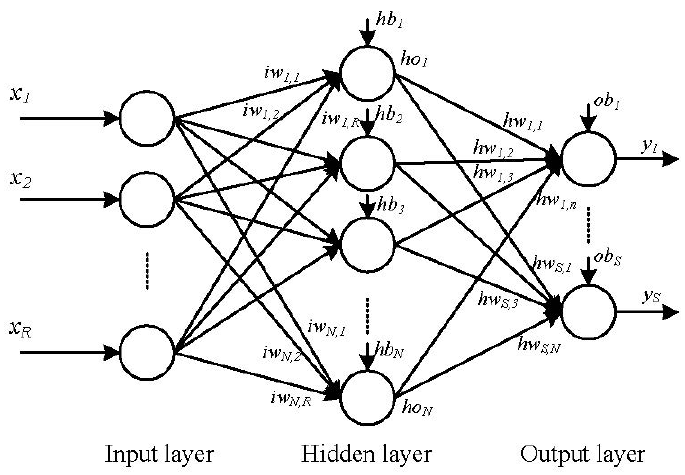
Figure 3. A feed-forward network with three